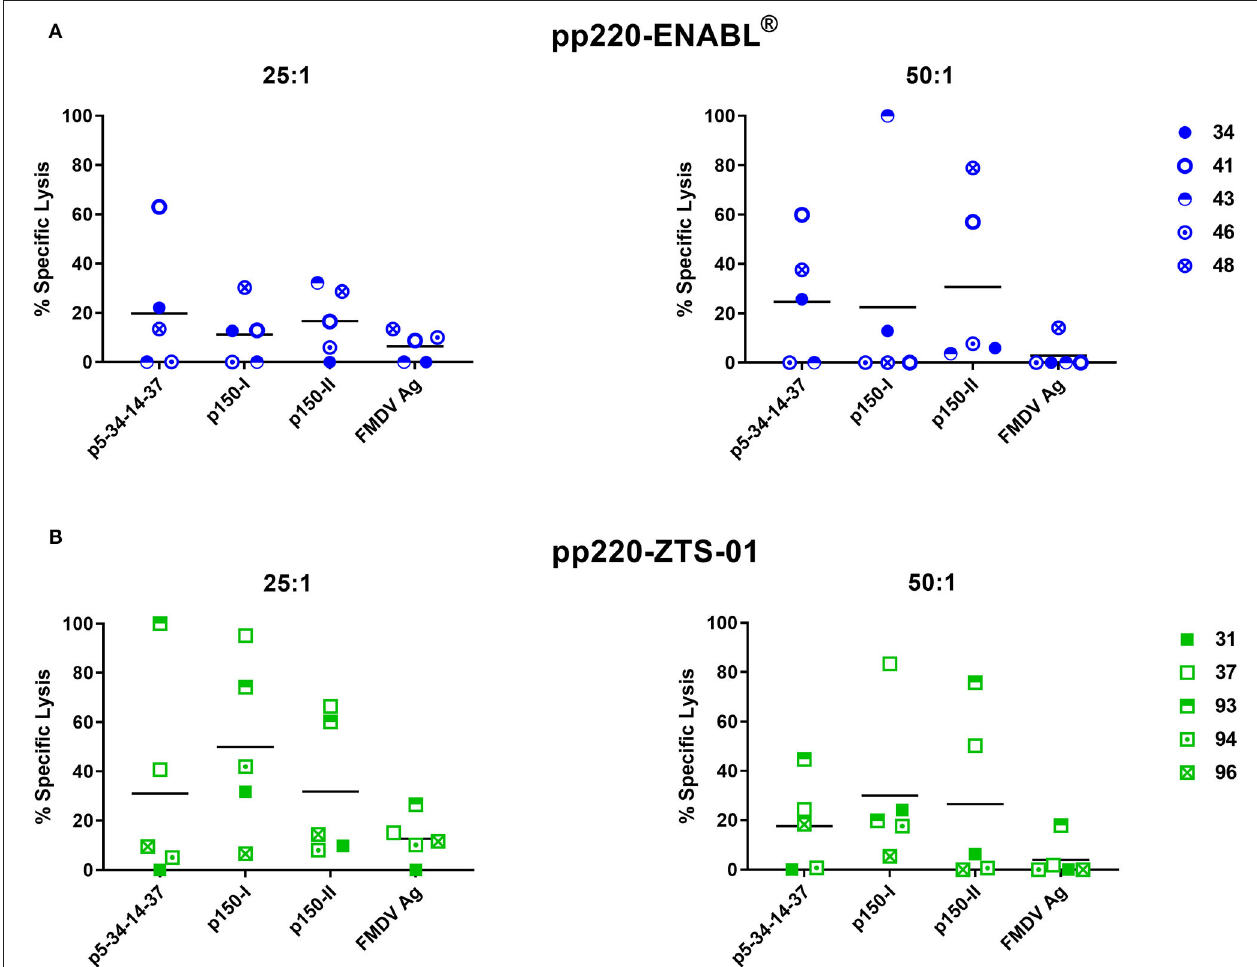
FIGURE 8 | Cytotoxic T-lymphocyte (CTL) responses against the pp220 antigens. At four weeks post-boost, p5-34-14-37-, p150-I-, and p150-II-specific CTL responses in PBMCs collected from (A) Ad-pp220-ENABL ® -immunized; or (B) Ad-pp220-ZTS-01-immunized pigs were evaluated at effector to target ratios of 25:1 and 50:1 using the standard 51 Cr release assay. Data are represented as the percent specific lysis against each antigen and a negative-control FMDV antigen (Ag). Mean responses for each antigen are denoted by